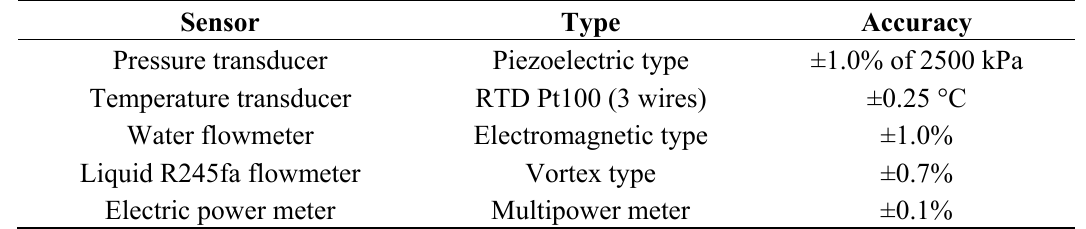
Table 1. Types and accuracies of sensors used in this